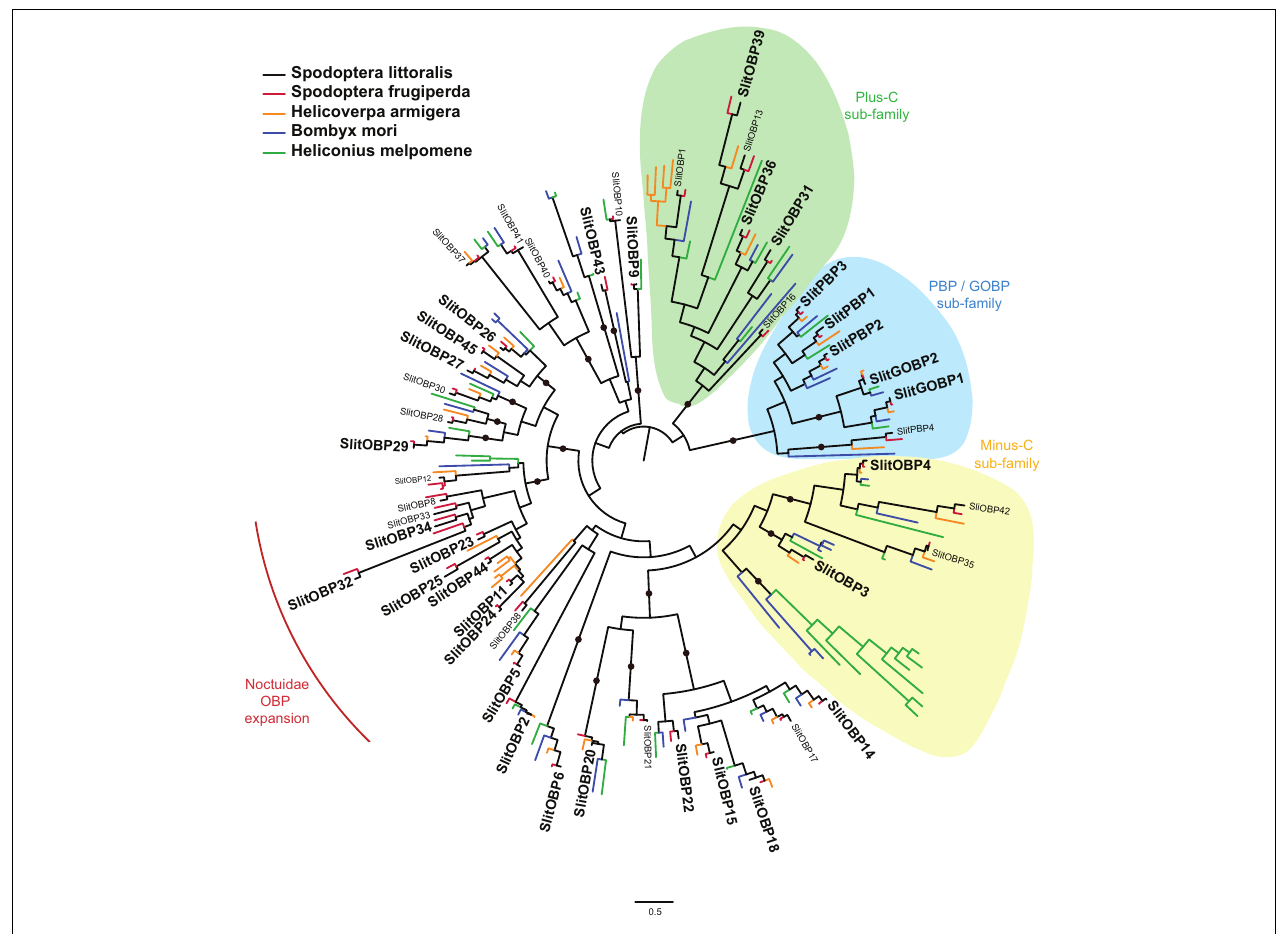
FIGURE 5 | Phylogenetic position of S. littoralis odorant-binding proteins (SlitOBPX, black). The midpoint rooted phylogeny was built using OBP repertoires of the moths S. frugiperda (red), H. armigera (yellow) and B. mori (blue), and the butterfly H. melpomene (green). SlitOBPs found in the present transcriptome are written in bold. The General OBP (GOBP) and Pheromone-Binding Protein (PBP) clade is designated with a light blue color shade. Plus and minus-C clades are highlighted with green and yellow shades, respectively. The noctuidae-specific OBP expansion is indicated by a red line. Clades supported by an aLRT value over 0.9 are indicated by a black